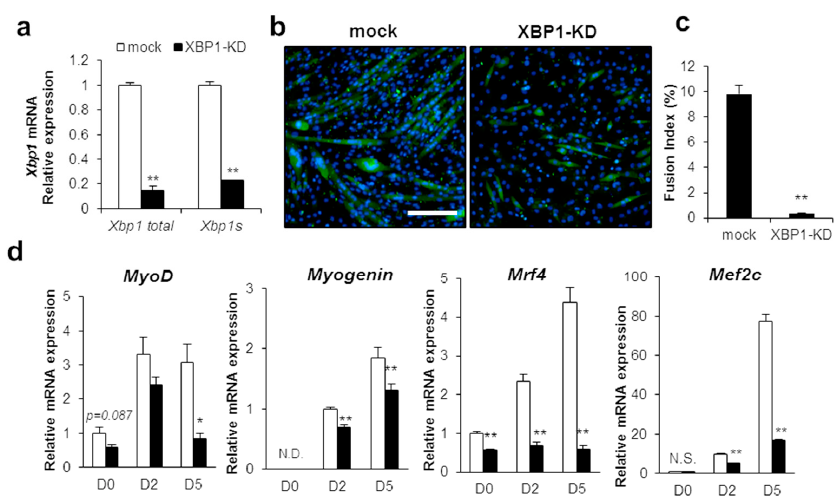
Figure 3. XBP1 is required for C2C12 differentiation. ( a ) mRNA expression of Xbp1 and spliced Xbp1 were compared between XBP1-knockdown cells (XBP1-KD) and mock cells. Results are means + SEM (three biological replicates). Student’s t -test. ** p < 0.01. ( b ) XBP1-knockdown cells and mock cells were induced to differentiate until day 5. Cells were observed for immunofluorescent staining with anti-MHC antibody. Scale bar = 200 µm. ( c ) Fusion index of mock or XBP1-KD cells. Results are mean + SEM (three biological replicates). Student’s t -test. ** p < 0.01. ( d ) Cells were harvested on the indicated day. mRNA expression of each myogenic factor was analyzed by qPCR. Results are means + SEM (three biological replicates). Student’s t -test. * p < 0.05, ** p < 0.01.